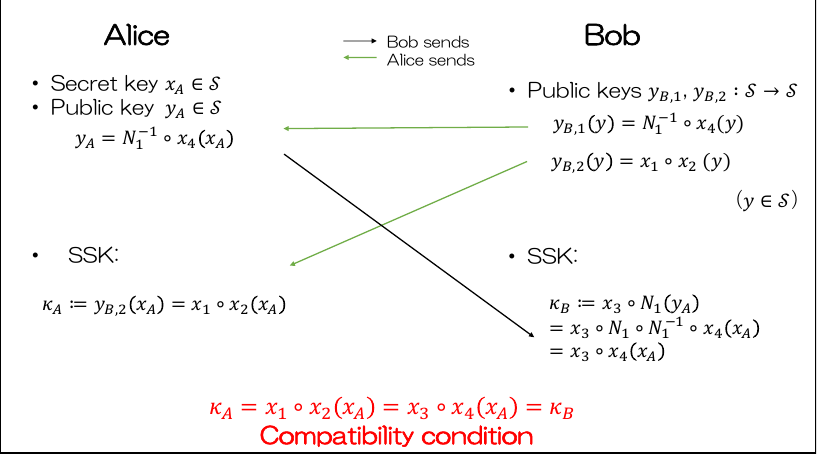
Figure 1. Key agreement process of